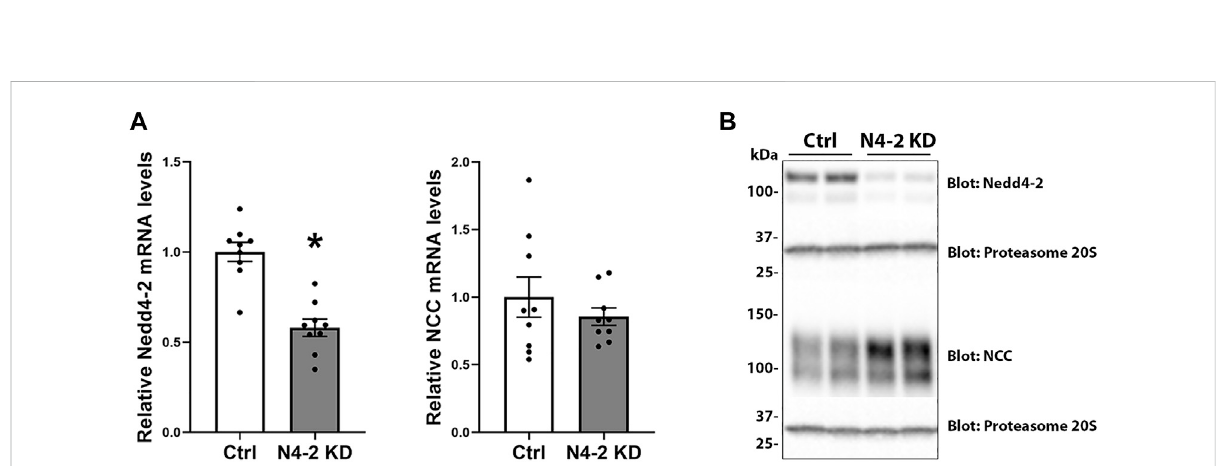
FIGURE 2 Nedd4-2mRNAandproteinlevelsinMDCKI-hNCCNedd4-2knockdown(N4-2KD)celllines. (A) mRNAlevelsofNedd4-2(left)andNCC(right) inMDCKI-hNCC CtrlandN4-2 KDcelllines. TherelativemRNAabundancesarecalculatedfromtheCtvalues usingthedelta-deltaCtmethod.Data aremeans±S.E.M.( n =9)* p < 0.05assessedbyunpairedStudent ’ sttest. (B) RepresentativeimmunoblotsofNedd4-2,NCC,andproteasome20Sin MDCKI-hNCC Ctrl and N4-2 KD cell